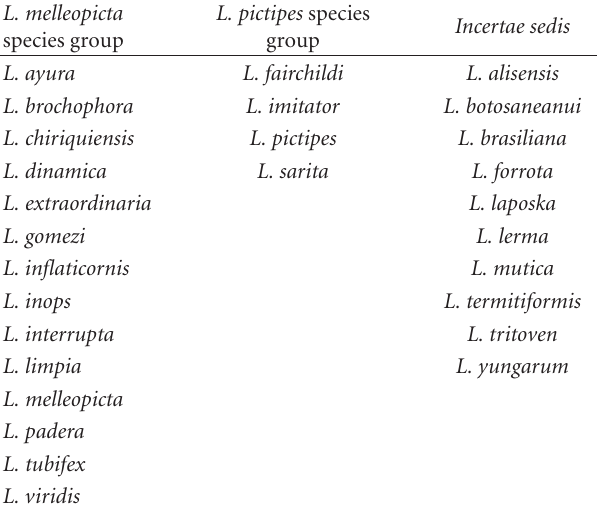
Table 2: Species groups of Leucotrichia